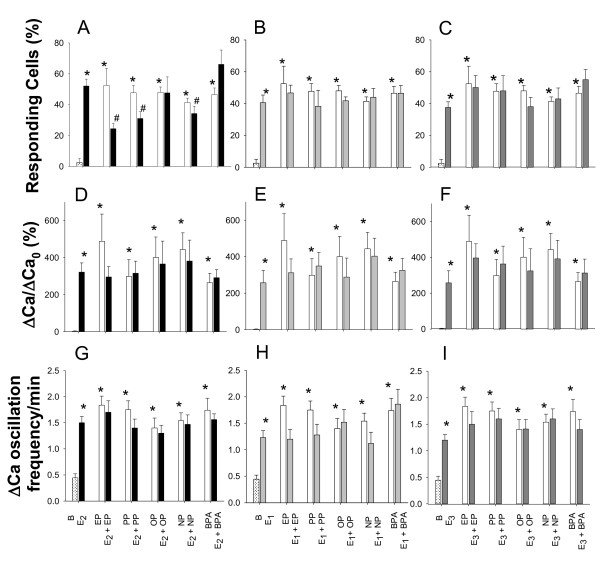
Changes in calcium responses elicited by physiologic estrogens (PE) and xenoestrogens (XE), alone and in combination. The level of Ca [compared to the pretreatment baseline (B) measurement for each assessed cell] was measured by Fura-2 imaging in cells treated with 10 pM E2, E1, or E3 or different 10 pM alkylphenols (EP, PP, OP, NP, or BPA), or physiologic estrogen and xenoestrogen combinations. (A-C) % of cells responding to estrogens; (D-F) changes in accumulated intracellular calcium levels; (G-I) changes of calcium oscillation frequency. Note - some baseline measurements (D-F) were too low to show up as bars on the graphs. * = p < 0.05 compared to control cells. # = p < 0.05 compared to E2, E1, or E3 alone.